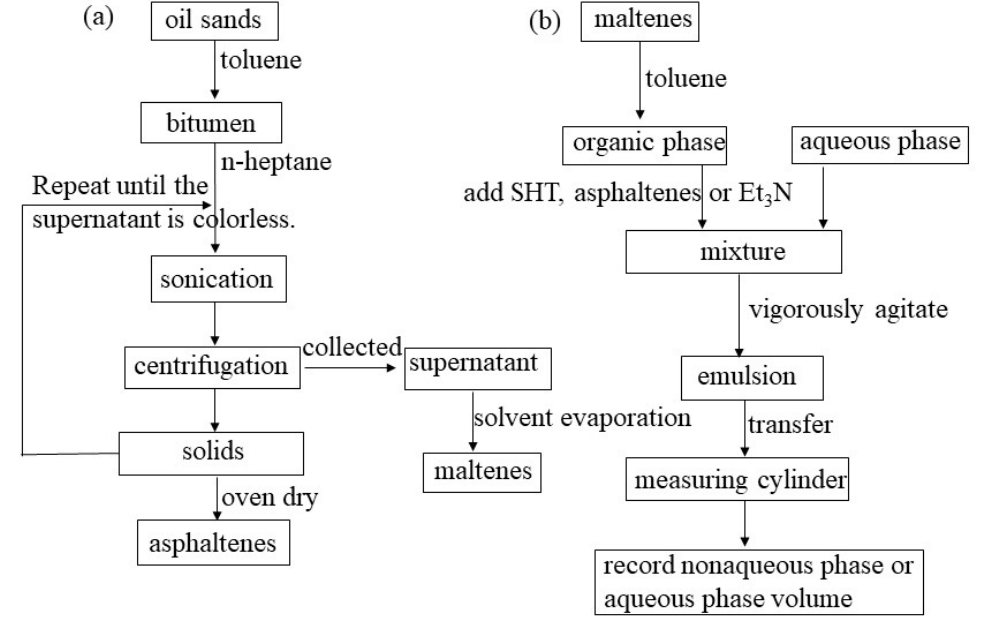
Figure 1. Schematic of the emulsion stability experiment procedures. ( a ) Preparation of asphaltenes and maltenes; ( b ) preparation of emulsions and the demulsification process.